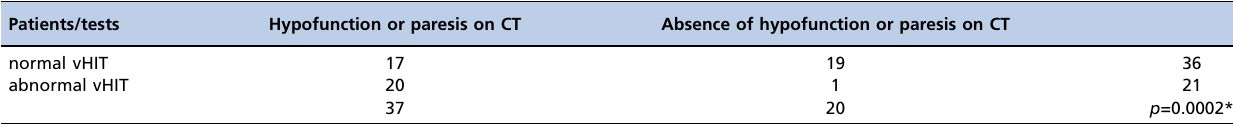
Table 2 - Results indicative of hypofunction or paresis on the CT and abnormal vHIT gain in our 114-ear sample before the CI procedure. The signal (*) indicates statistical